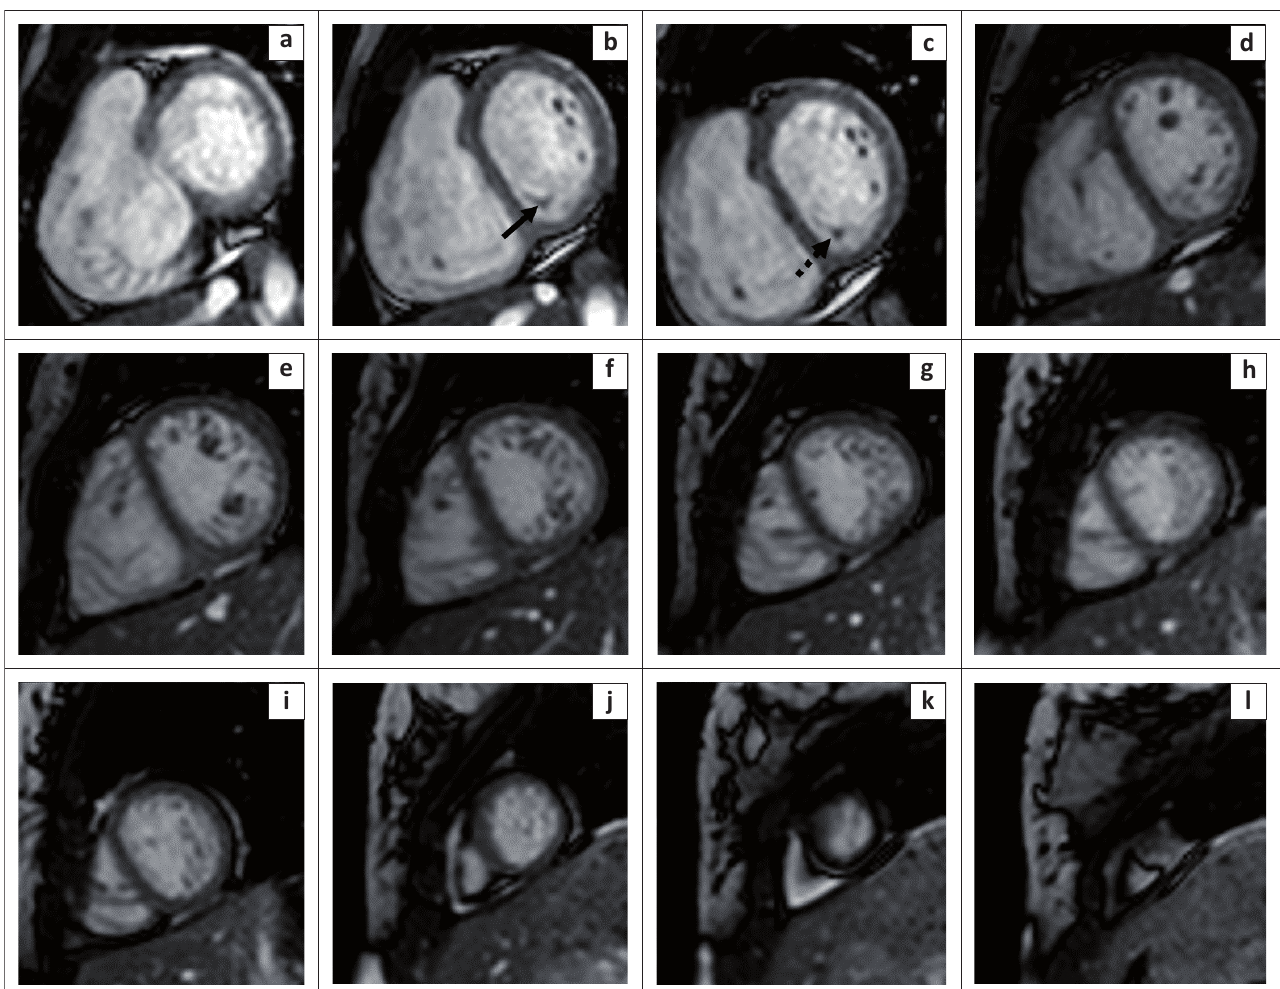
FIGURE 2: A series (a–l) of short-axis cine SSFP images of the LV during a single phase at different slice positions. Slices that repeat the same slice position should be deleted to prevent over-sampling. This is easily determined by observing the configuration of the papillary muscles; the papillary muscle of the second slice (solid black arrow) is in the exact same position and configuration as the papillary muscles of the third slice (stippled black arrow), hence one of these slices must be deleted and not included in the LV volume and mass assessment.